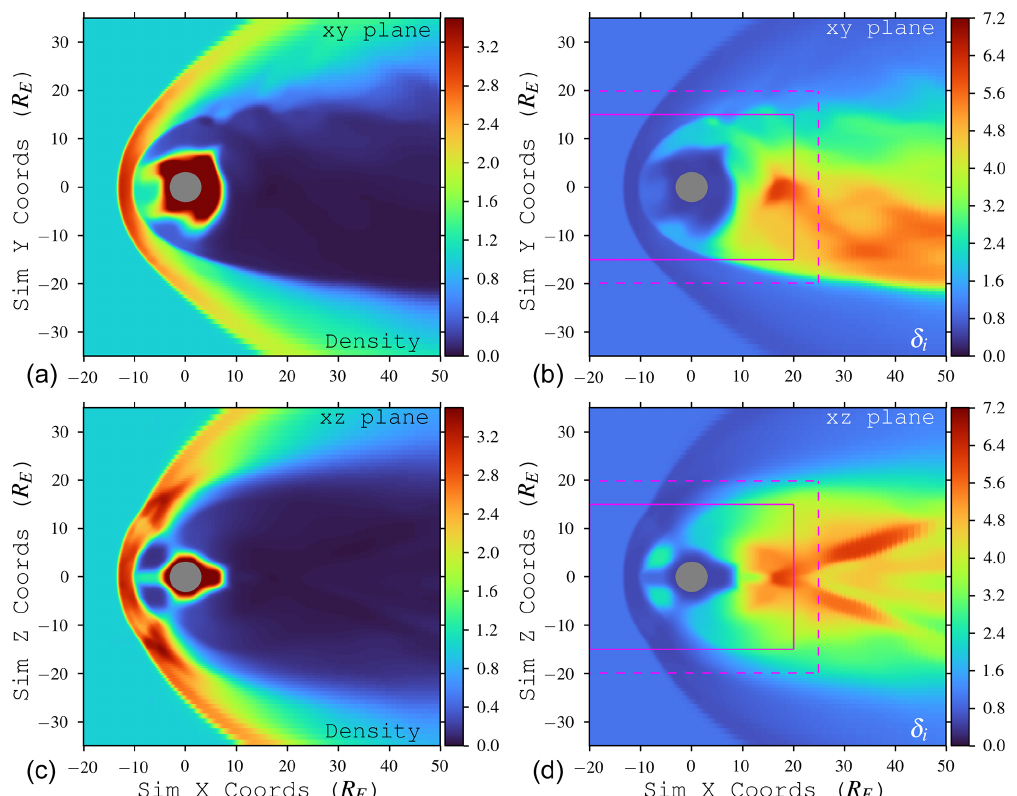
. √ 1 /ρ in the xy (a, b) and xz planes (c, d) , taken from an example